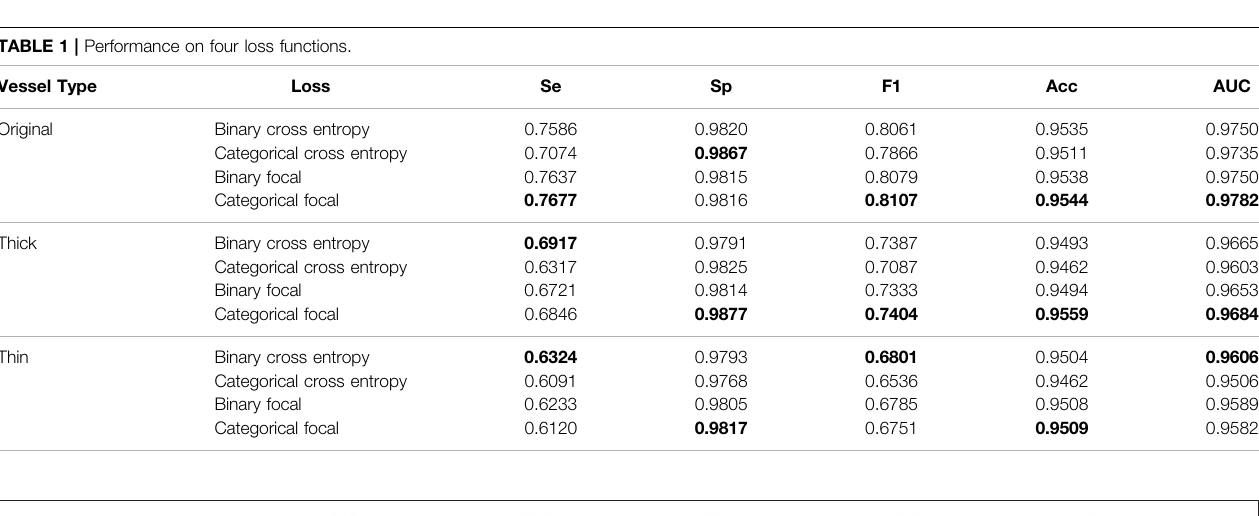
TABLE 1 | Performance on four loss functions.